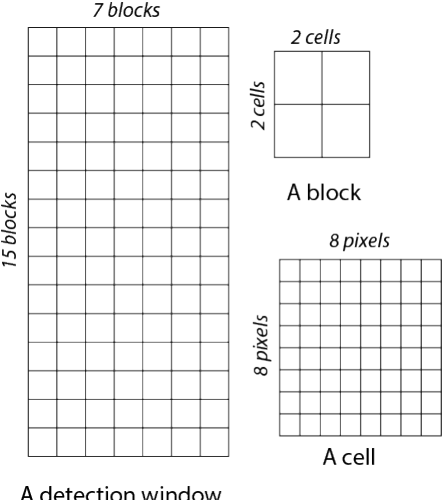
Figure 7. Size of a detection window, a block, and a cell.